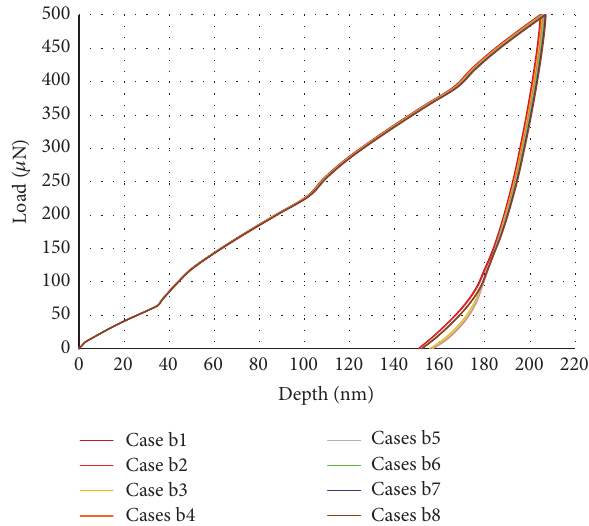
Figure 6: The load-depth curves of series 2.